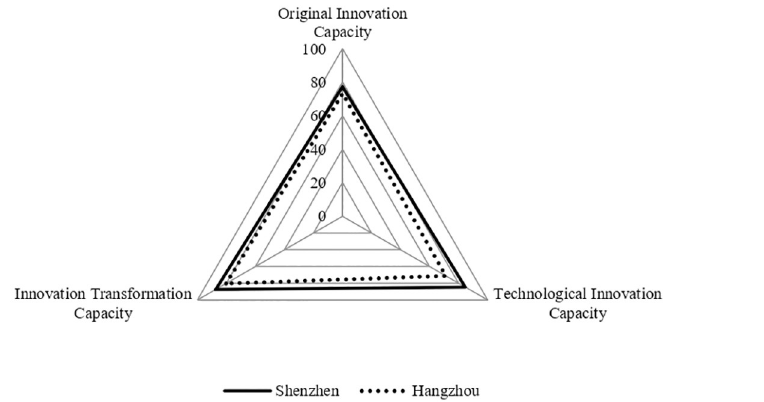
Fig 6. Three capacities of UICs in cities with high innovation performance.